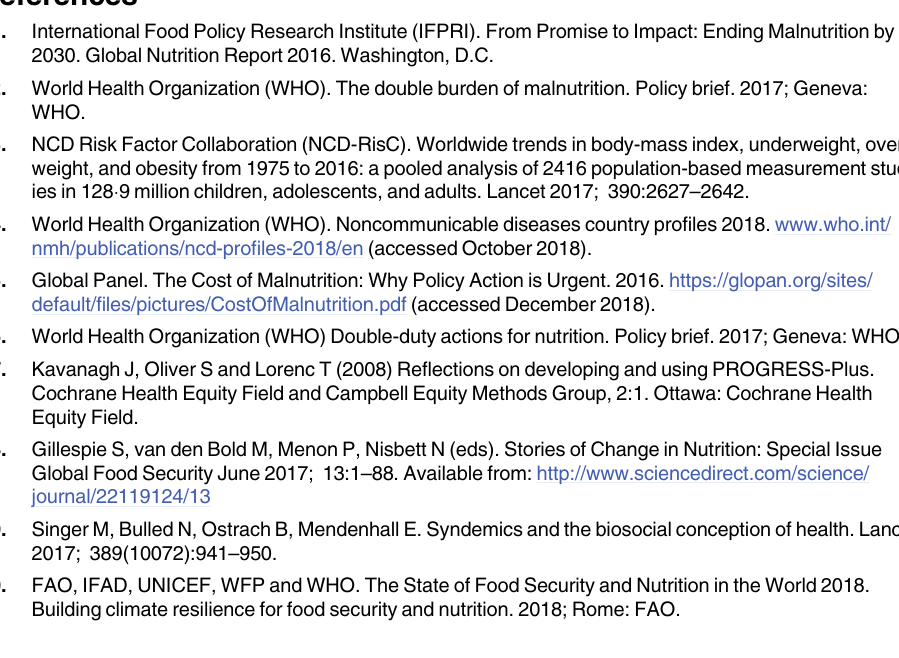
S1 Table. Critical appraisal. Adapted from WHO (2011) ‘Good Practice Appraisal Tool for Obesity Prevention Programmes, Projects, Initiatives and Interventions’. Studies marked with � are to be considered in conjunction with other studies on the same interventions. S2 Table. Assessment of double duty action eligibility. Legend: Y = Yes; N = No; N/ A = unclear / lack of detail for in-depth analysis of single components; - = need for in-depth analysis of single